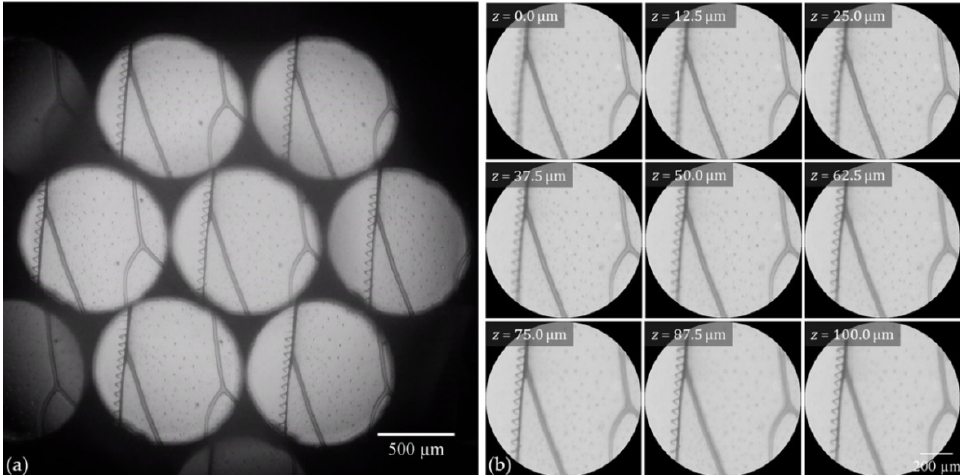
Figure 4. ( a ) Elemental images of a honeybee wing captured using the handheld and cost-effective FLMic; ( b ) refocused images at different depth planes. The scale bar indicates the equivalent distance in the object space.